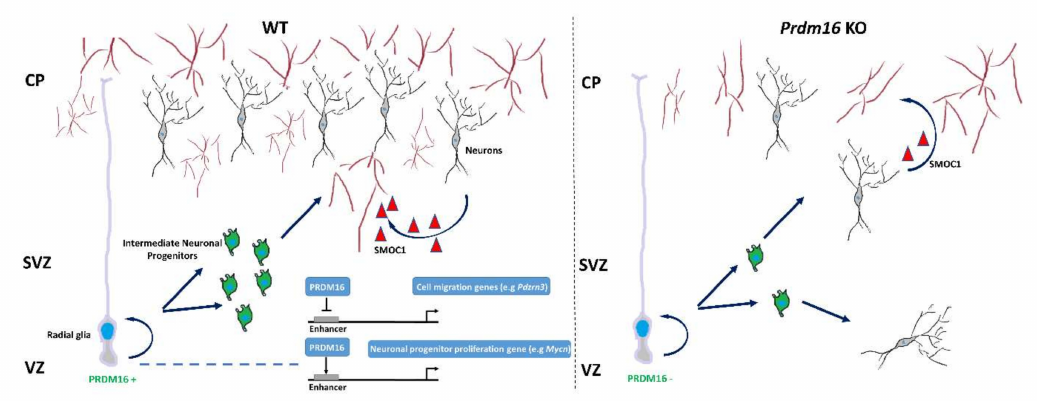
Figure 3. PRDM16 orchestrates neuronal migration and angiogenesis in the developing brain. PRDM16 organizes the migration of cortical neurons through enhancer-dependent silencing of Pdzrn3 gene expression. In addition, PRDM16 controls the expression of genes associated with the amplification of neuronal progenitors (e.g., Mycn ) [24]. PRDM16 positively regulates neuronal angiogenesis by enhancing the TGF- β signaling pathway via neuronally secreted SMOC1 [114]. VZ (ventricular zone), SVZ (subventricular zone), CP (cortical